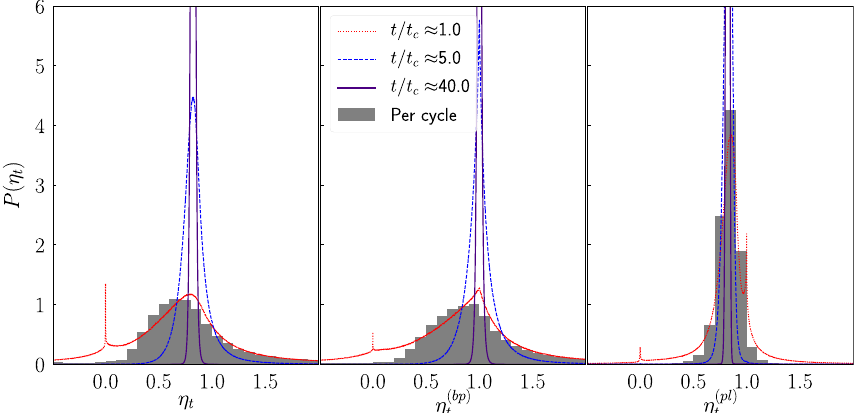
Figure 10. Pdf of the efficiency obtained from an ensemble of systems with p = 0.2 and M l = 1 . The bar plots refer to the actual efficiency per cycle of the engine, while the lines represent the efficiency pdf obtained by sampling several time windows of size t .